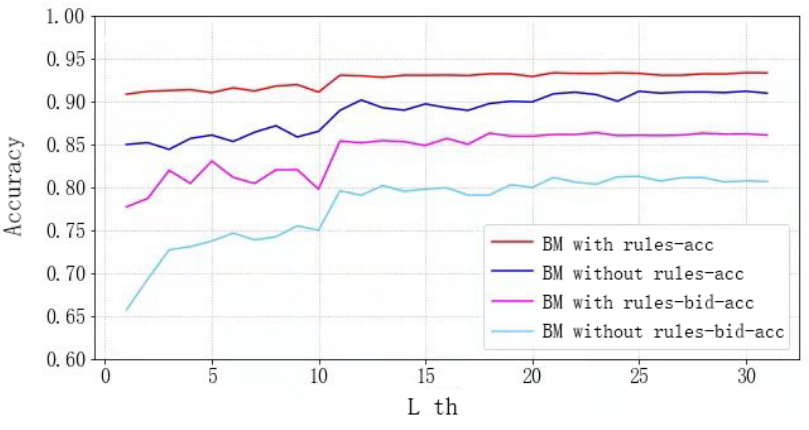
Figure 9. Accuracy of different